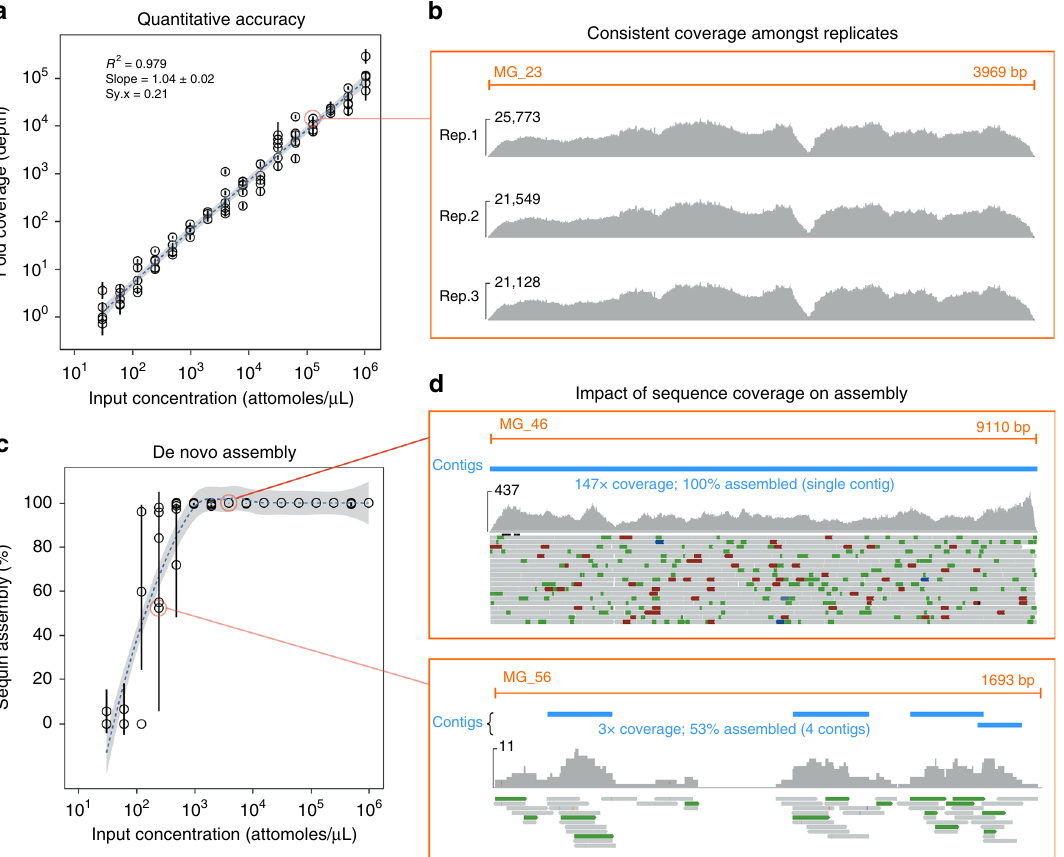
Fig. 2 Using sequins to assess quantitative accuracy and de novo assembly. a Scatter plot shows measured fold-coverage for each sequin plotted against its known input concentration, in triplicate. Error bars indicate standard deviation (SD) between replicates. A linear regression model is fi tted to the data (dotted line) with 95% con fi dence interval shown (gray shading). b By sequencing a neat preparation of the staggered sequins mixture (Mix A) in triplicate, we observed the same coverage patterns and biases in each replicate. Example shows genome browser views of the sequencing coverage for three replicates of a randomly chosen sequin, MG_23 . c Scatter plot shows the fraction of each sequin de novo-assembled plots against its known input concentration, in triplicate. Error bars indicate SD between replicates. d Genome browser views of two sequins demonstrate the impact of sequence coverage on assembly. MG_46 (top) shows high sequence coverage, and was fully assembled in a single contig. By contrast, MG_56 (bottom) has low sequence coverage and was only partially assembled with four fragmented